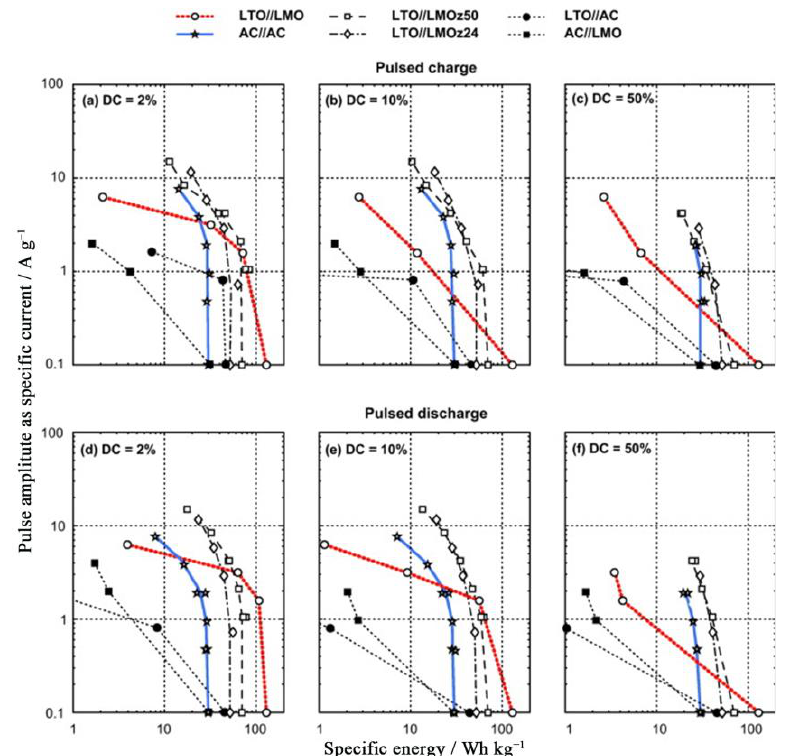
Figure 13. The profiles of pulsed specific current versus specific energy for the different systems. Pulsed charge: duty cycle (DC) of ( a ) 2%, ( b ) 10%, and ( c ) 50%; Pulsed discharge: DC of ( d ) 2%, ( e ) 10%, and ( f ) 50% [36].